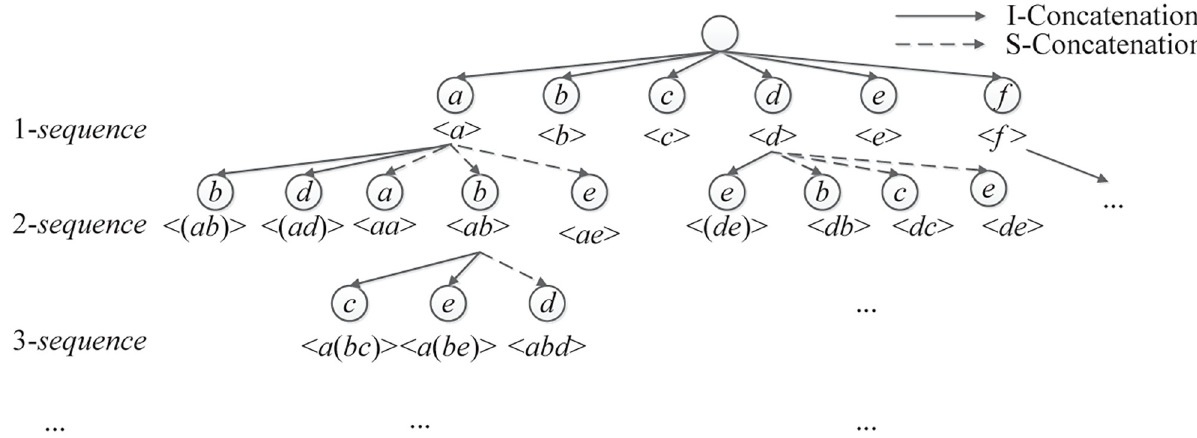
Fig 3. A lexicographic sequence